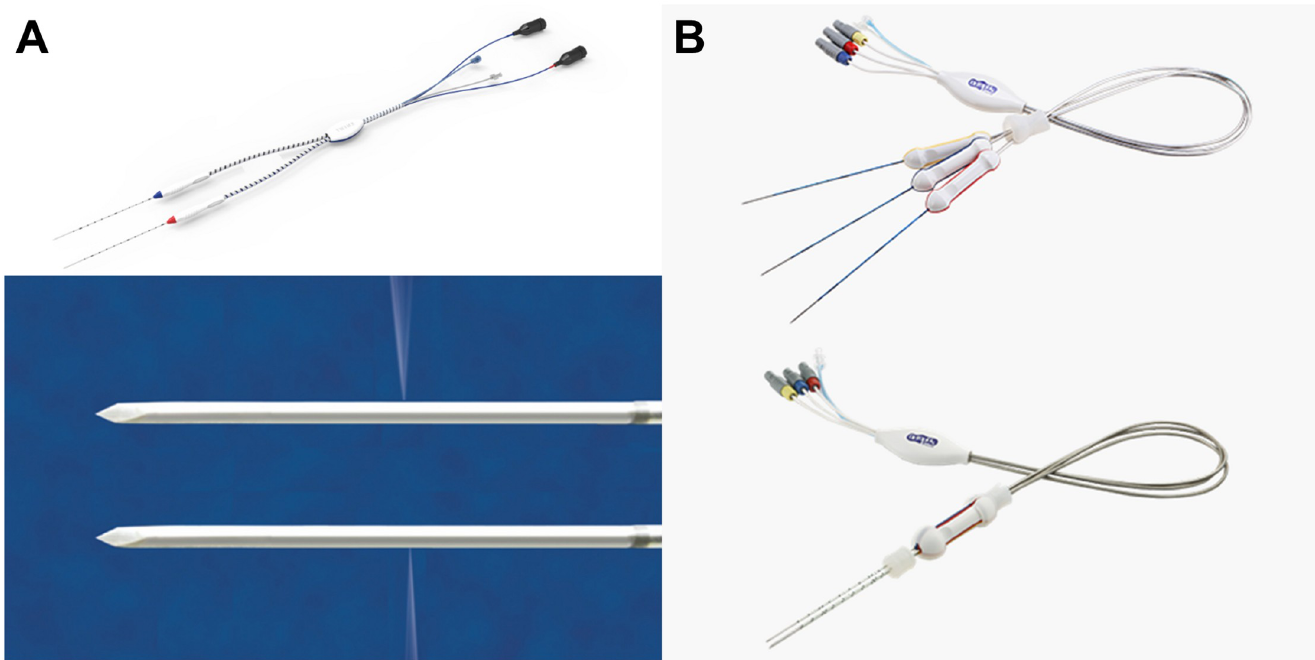
Fig 2. Photographs of (A) twin internally cooled wet (TICW) electrodes (CWTN-T, RF Medical, Seoul, Korea) and (B) separable clustered (SC) electrodes with three active tips (Octopus, STARmed, Goyang, Korea).